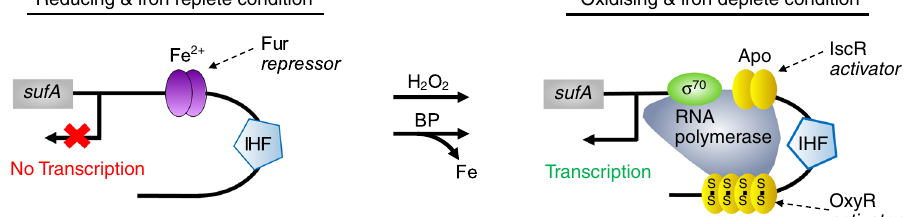
Fig. 3 Regulation of transcription of the σ 70 controlled Suf system. The Suf system enables the assembly of Fe-S clusters of bacteria under oxidative stress and iron limitation 28,29,40 – 43 . Under reducing and iron replete conditions, transcription from the Suf promoter is repressed by Fur[Fe 2 + ], preventing access of RNA polymerase/ σ 70 and the activator IscR to the promoter. The reduced form of the activator OxyR under these conditions has low af fi nity for the promoter. Under oxidising and iron deplete conditions (e.g. in presence of H 2 O 2 and bipyridyl, BP), the oxidsed form of OxyR[S-S] and the Apo form of IscR have higher af fi nity for the promoter than the oxidised and/or Apo form of Fur. Integration Host Factor (IHF) bends the promoter DNA bringing OxyR [S-S] and RNA polymerase/ σ 70 into close contact. OxyR[S-S] and the Apo form of IscR stabilise the contact of RNA polymerase/ σ 70 with the promoter resulting in